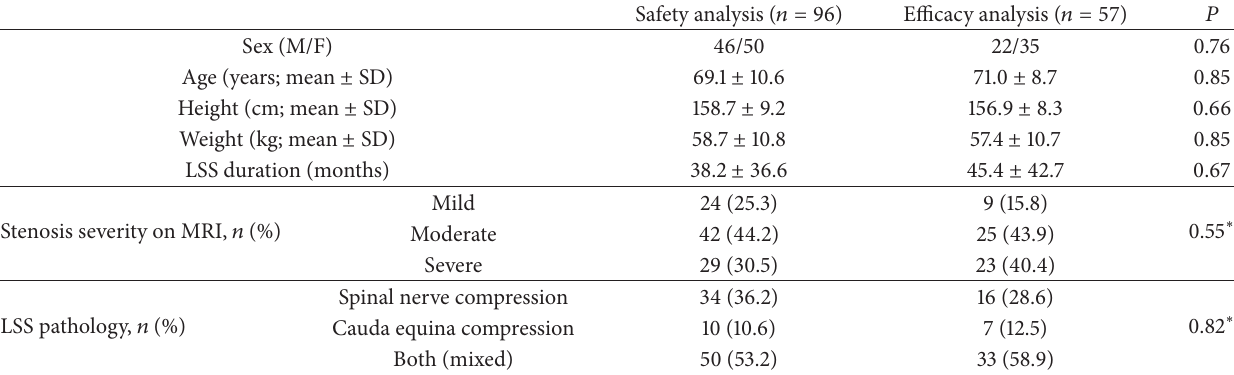
Table 2: Patient